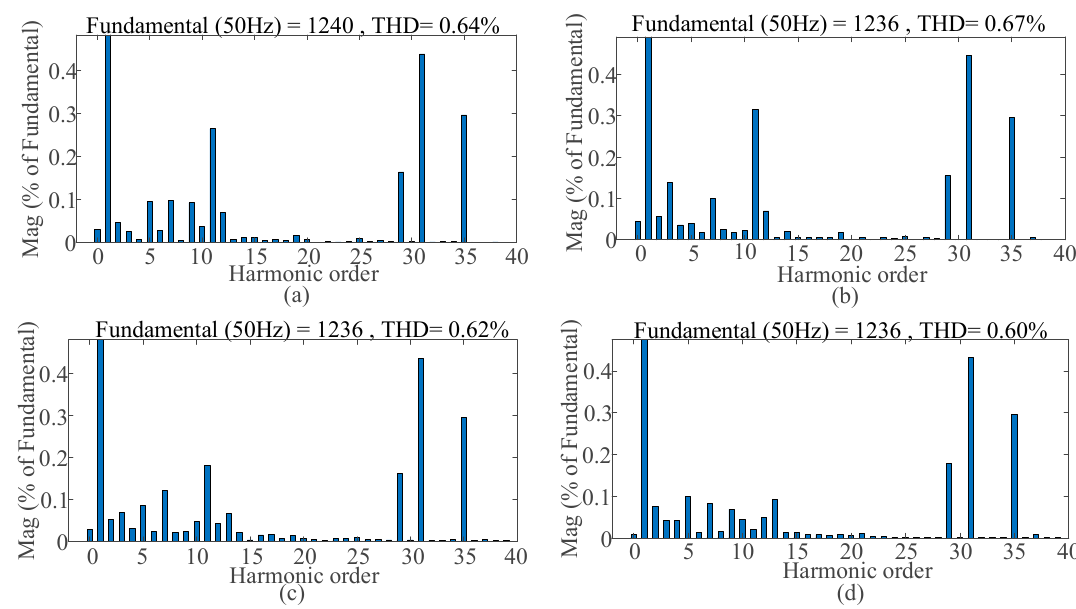
Figure 21. The THD analysis of phase A current at different duration of dead time, T d = 20 𝜇𝑠 ( a ), T d = 30 𝜇𝑠 ( b ), T d = 40 𝜇𝑠 ( c ), T d = 50 𝜇𝑠 ( d ), with the proposed closed-loop dead-time compensation applied.